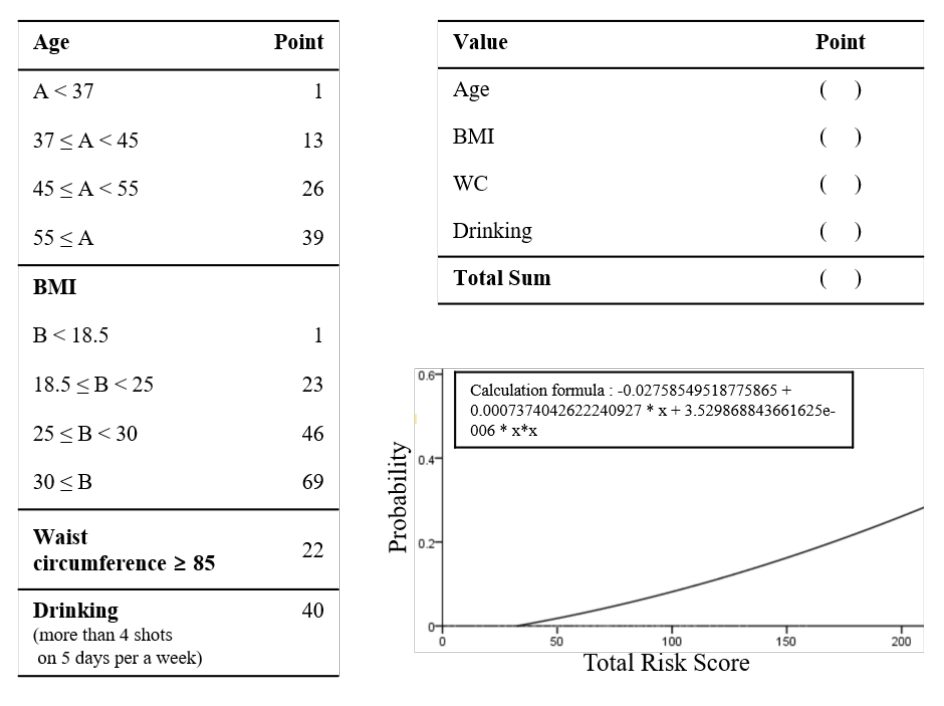
Figure A1. Screening model for estimation of UDM in male and female populations with FHD.